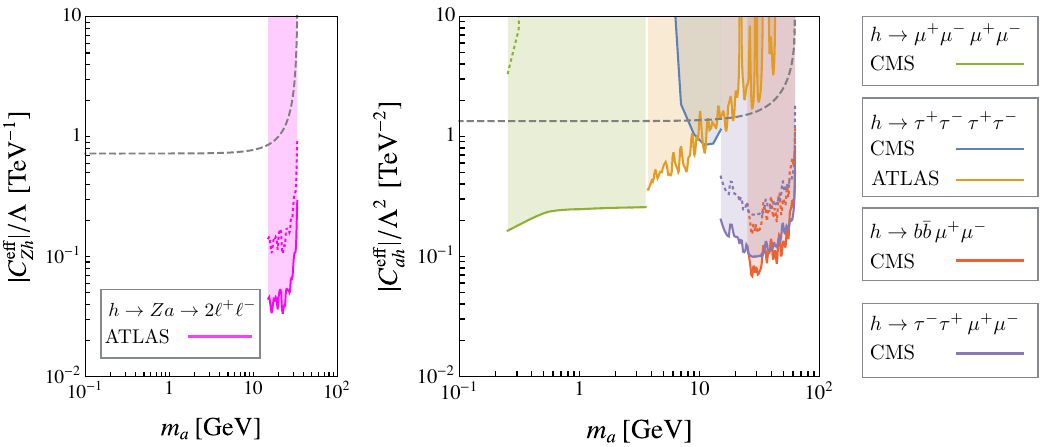
Figure 13 . Left: parameter space excluded by a search for h ZZ d 2 ‘ + ‘ (cid:0) , assuming Br( a ! ! ! ‘ + ‘ (cid:0) ) = 1 (solid line) and Br( a ‘ + ‘ (cid:0) ) = 0 : 1 (dotted line). Right: constraints from dedicated ! LHC searches for h aa with subsequent ALP decays into fermion pairs. The solid contours ! assume Br( a ‘ + ‘ (cid:0) ) = 1 if all fermions have the same (cid:13)avor, and Br( a (cid:22) + (cid:22) (cid:0) ) = Br( a ! ! ! (cid:28) + (cid:28) (cid:0) ) = Br( a b (cid:22) b ) = 0 : 5 otherwise. The dotted contours correspond to Br( a ‘ + ‘ (cid:0) ) = 0 : 1 if ! ! all fermions have the same (cid:13)avor, and Br( a (cid:22) + (cid:22) (cid:0) ) = 0 : 1, Br( a (cid:28) + (cid:28) (cid:0) ) = Br( a b (cid:22) b ) = 0 : 9 ! ! ! otherwise. The gray dashed lines indicate the model-independent bounds (5.11) and (5.16).